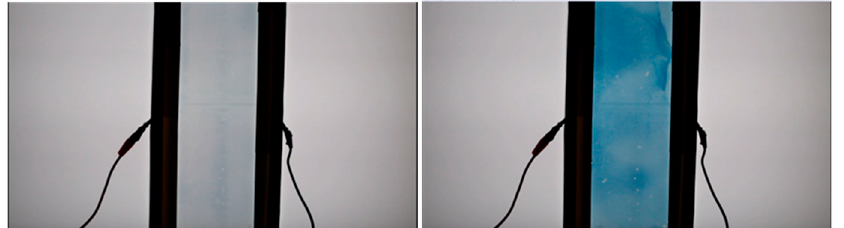
Figure 5. Clear and dark states of a 360 cm 2 active area PEDOT-PSS/V 2 O 5 assembled device, under D65 standard illumination conditions, cycled between +0.5 V to − 4